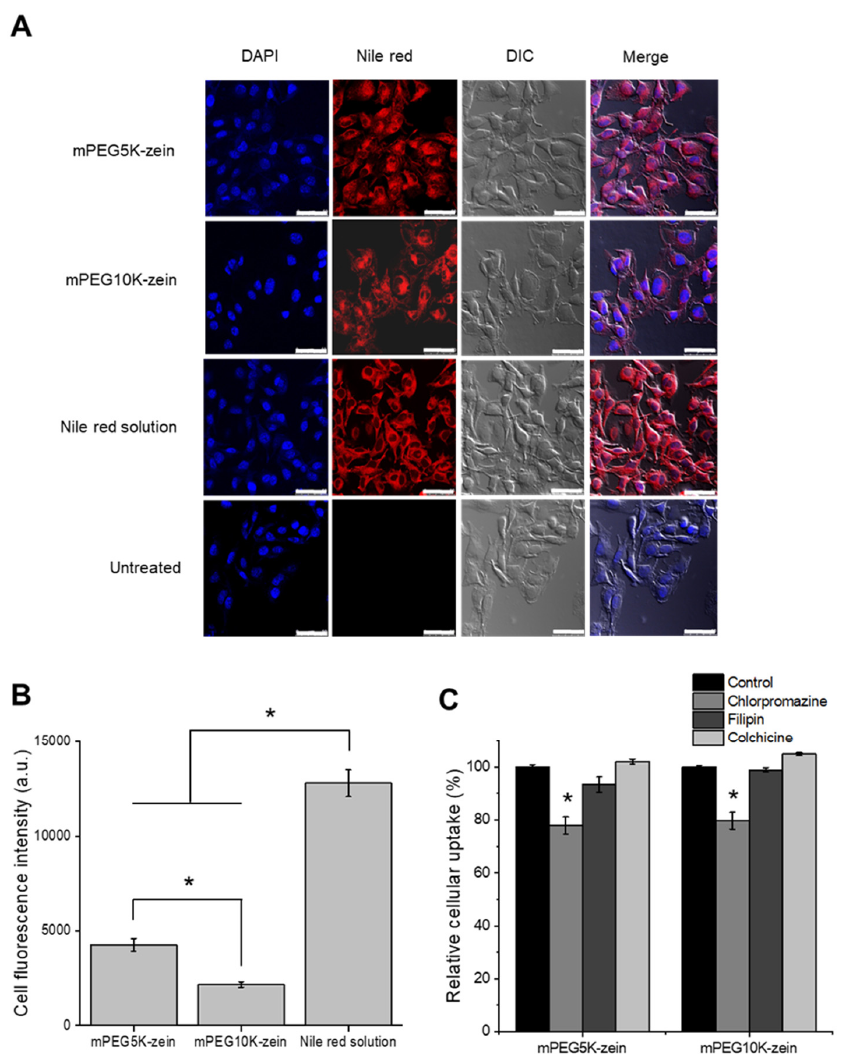
Figure 3. Uptake of mPEG ‐ zein micelles by B16 ‐ F10 ‐ luc ‐ G5 cells. ( A ) Confocal images of B16 ‐ F10 ‐ luc ‐ G5 cells after incubation with Nile red loaded in mPEG ‐ zein micelles, or as a solution (DIC: differential interference contrast), (scale bar: 50 μ m). ( B ) Flow cytometry analysis of the cellular uptake of Nile red loaded in mPEG ‐ zein micelles or as a solution (a.u.: arbitrary units) ( n = 3) (*: p < 0.05). ( C ) Effects of endocytosis inhibitors on the cellular uptake of Nile red ‐ loaded mPEG ‐ zein micelles ( n = 3) (*: p < 0.05, compared with control).